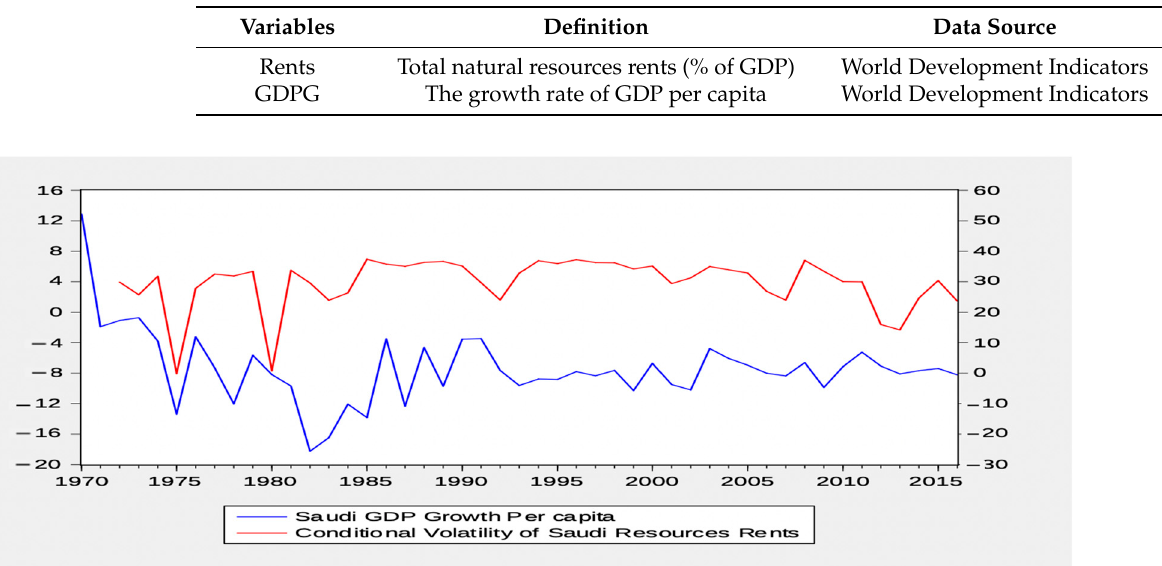
Figure A1. Conditional volatility of Saudi Arabia.